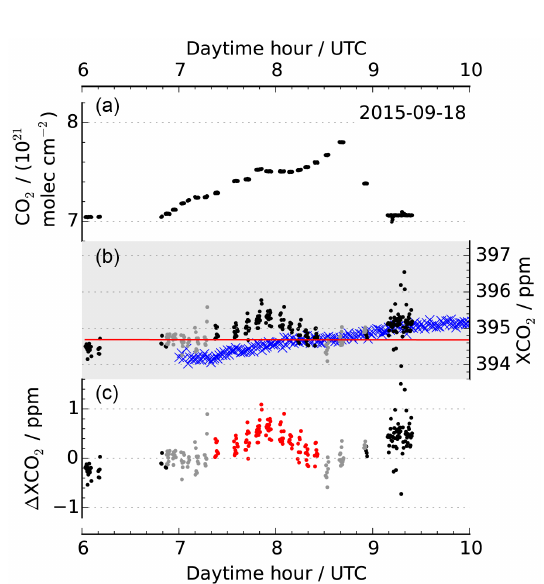
Figure 4. Derivation of (cid:49)X CO 2 for the spectra collected by the mobile FTS on 18 September 2015. The upper panel shows the CO 2 VCDs retrieved by the spectral retrieval described in Sect. 4.1. The middle panel shows the column-averaged dry-air mixing ra- tio XCO 2 (black and grey dots) calculated via Eq. (1). Background measurements (grey) are used to fit the linear background polyno- mial illustrated by the red line. Blue crosses show the measurements collected by the stationary FTS at the eastern slope of Mt. Etna. The lower panel depicts the volcanic XCO 2 enhancement ( (cid:49)X CO 2 ) cal- culated according to Eq. (2). Red circles are considered intra-plume